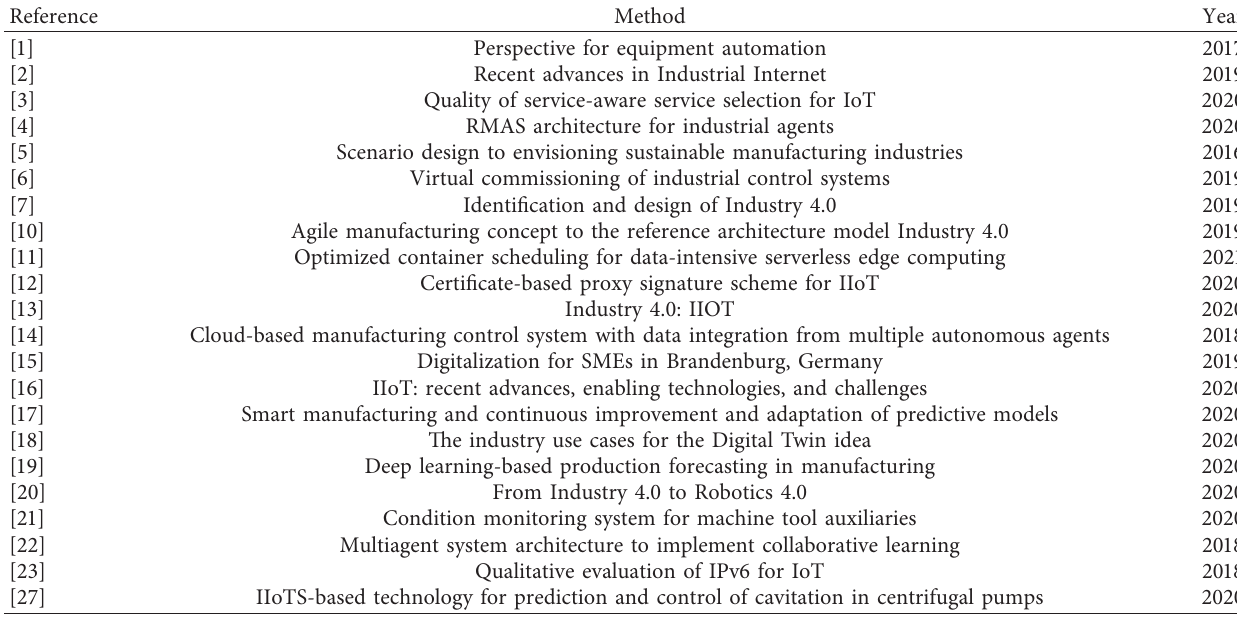
Figure 3: Subject, paper types, and the publications numbers. Table 1: Existing approaches related to the proposed